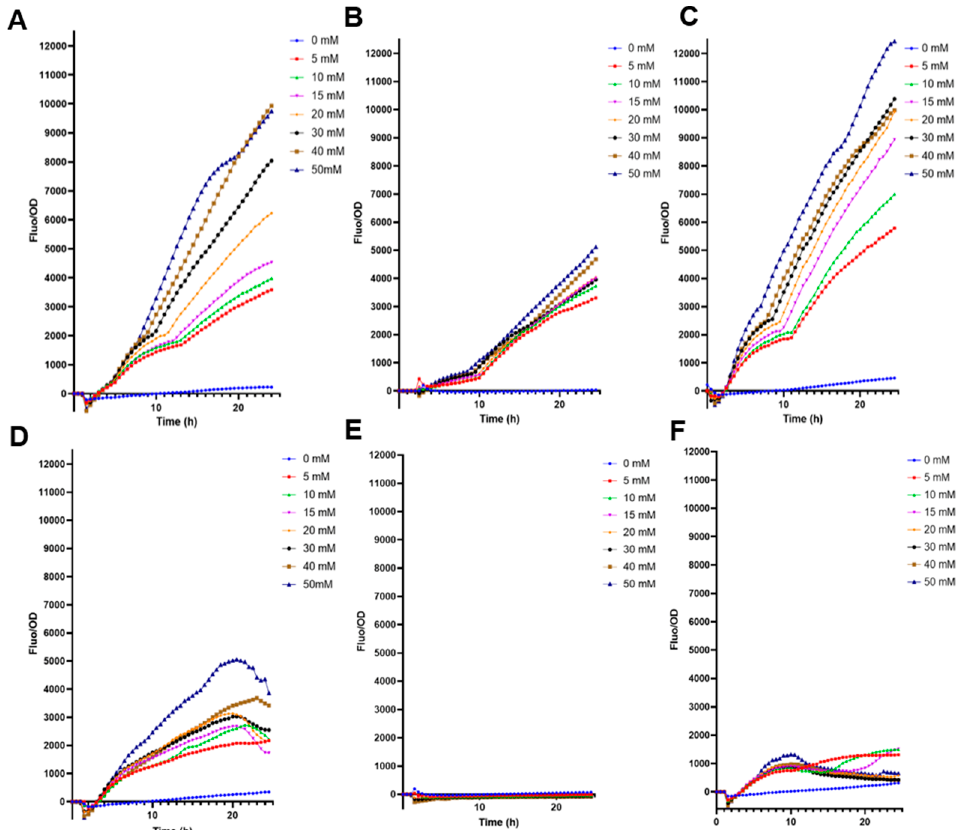
Figure 1. Fluorescence kinetics of different E. coli biosensors in response to increasing fucose concentrations. ( A ) E. coli BL21 containing pFuc_sfGFP_colE1; ( B ) E. coli BL21 containing pFuc_sfGFP_SC101; ( C ) E. coli BL21 containing pFuc_FucR1_colE1; ( D ) E. coli DH5 α containing pFuc_sfGFP_colE1; ( E ) E. coli DH5 α containing pFuc_sfGFP_SC101; ( F ) E. coli DH5 α containing pFuc_FucR1_colE1. Kinetic curves were performed in triplicates.